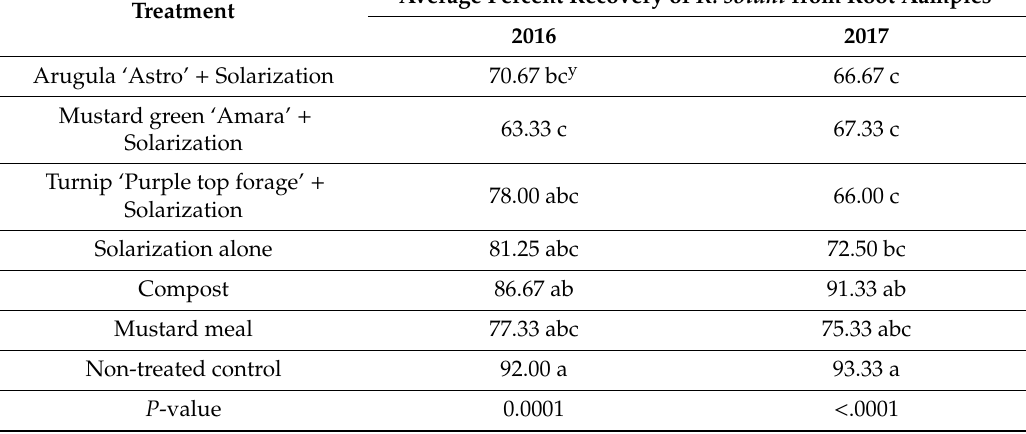
x For each plant, ten randomly selected flowering cherry root samples were plated on Rhizoctonia semi-selective medium to determine the percent recovery of R. solani from root samples. y Values are the means of three replicates; treatments followed by the same letter within a column are not significantly di ff erent at P ≤